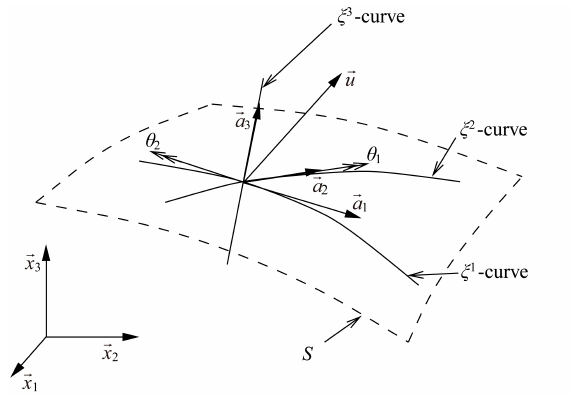
Figure 2. Coordinates of a shell